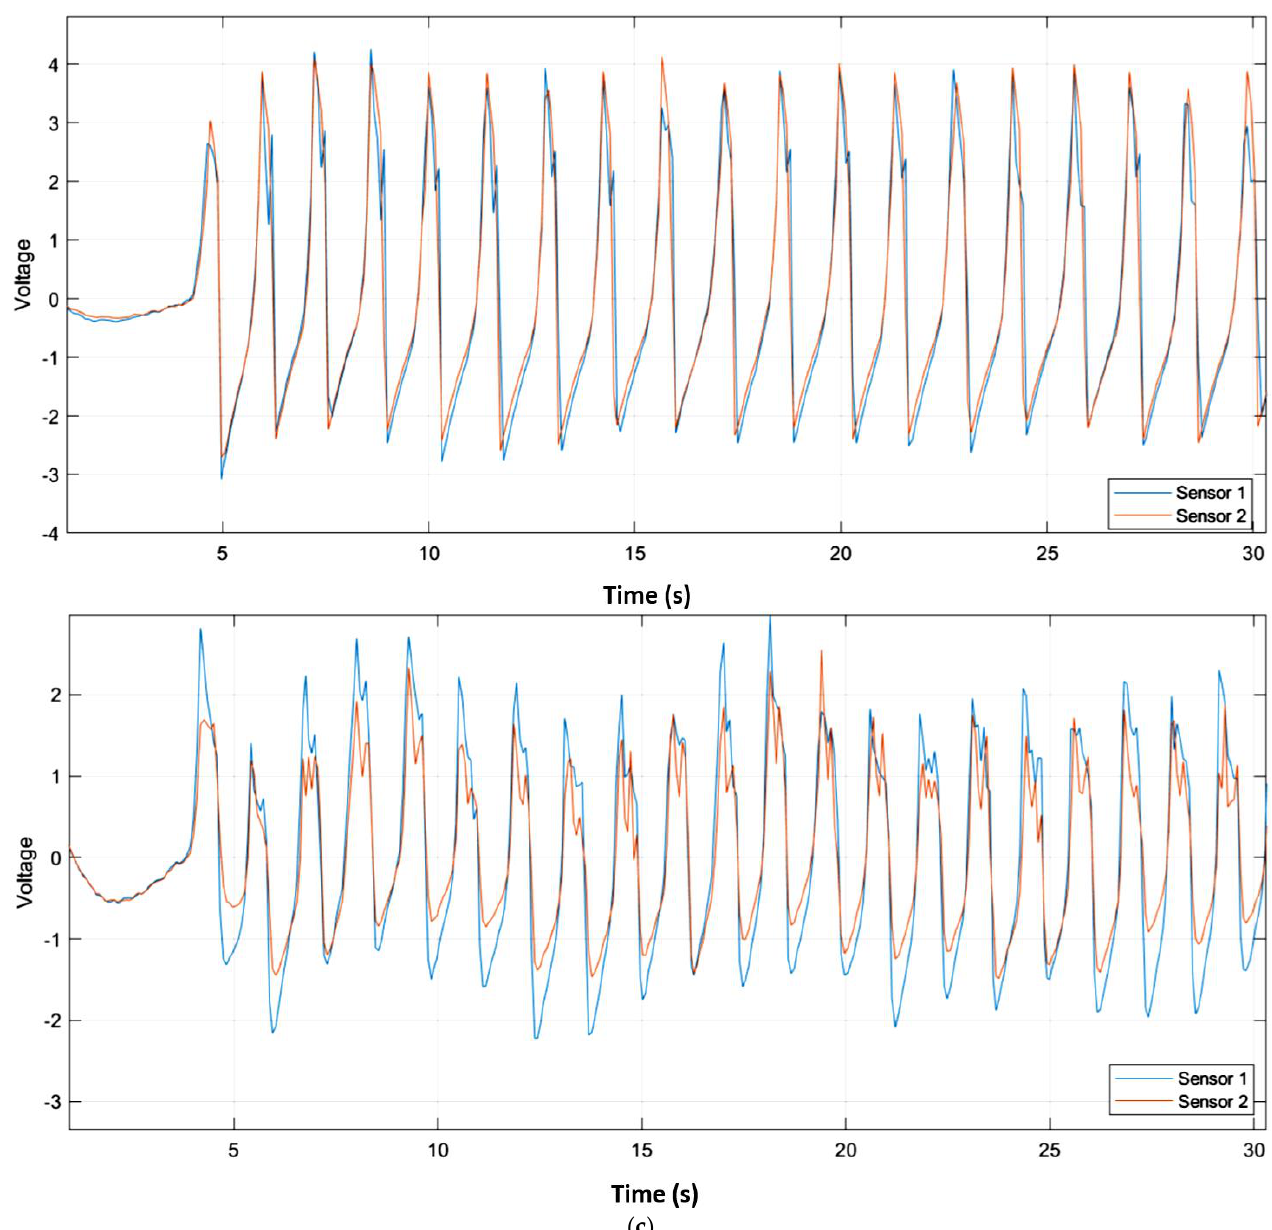
Figure 6. Data acquisition results of slapping, squeezing, and tickling from top to bottom, respectively, on ( a ) square, ( b ) round, and ( c ) triangle silicone modules.